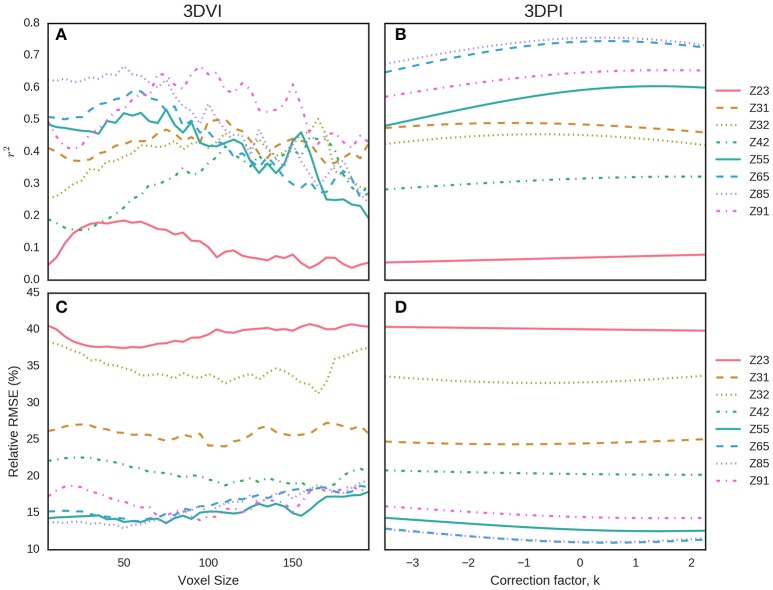
Determination of the optimum parameters for 3DVI (voxel size) and 3DPI (k) for the estimation of above-ground biomass from EXP3 at eight sample events. For each parameter value, the r2
(A,B) and relative RMSE (%) (C,D) of the linear regression with above-ground biomass were calculated. For 3DVI, voxel sizes ranged from 10 to 200 mm, at 10 mm increments (A,C). For 3DPI, k ranged from −3.5 to 2.25 at increments of 0.05 (B,D).